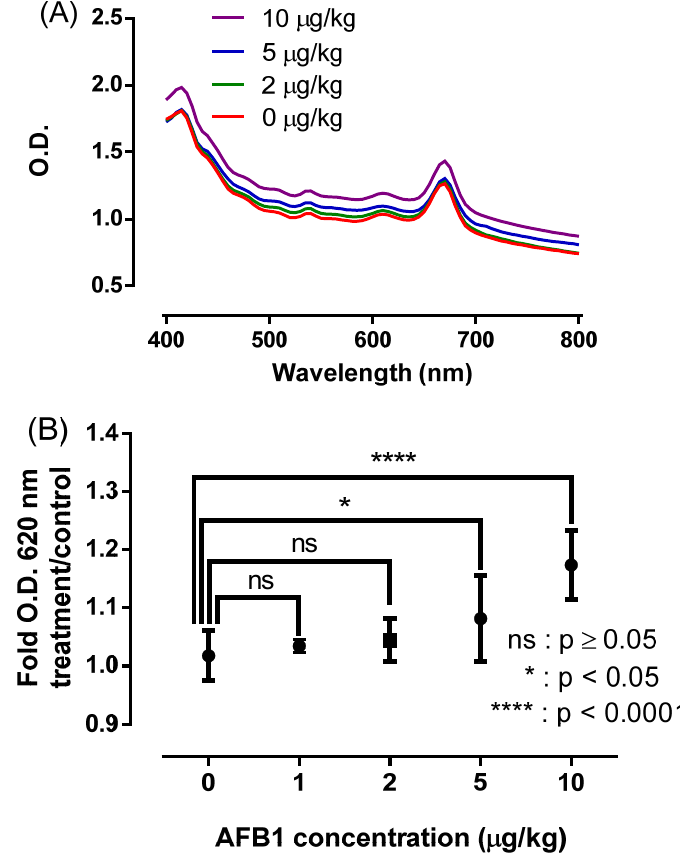
Figure 5. NAS-based detection assay of AFB1 present in cattle feed using acetonitrile as the extractant agent, showing ( A ) the absorption spectra in the crude extract and ( B ) AFB1 detection using O.D. at 620 nm. The results were averaged from three independent experiments (n = 3). Statistically significant differences compared with the controls and different treatments are indicated. * p < 0.05 and **** p <